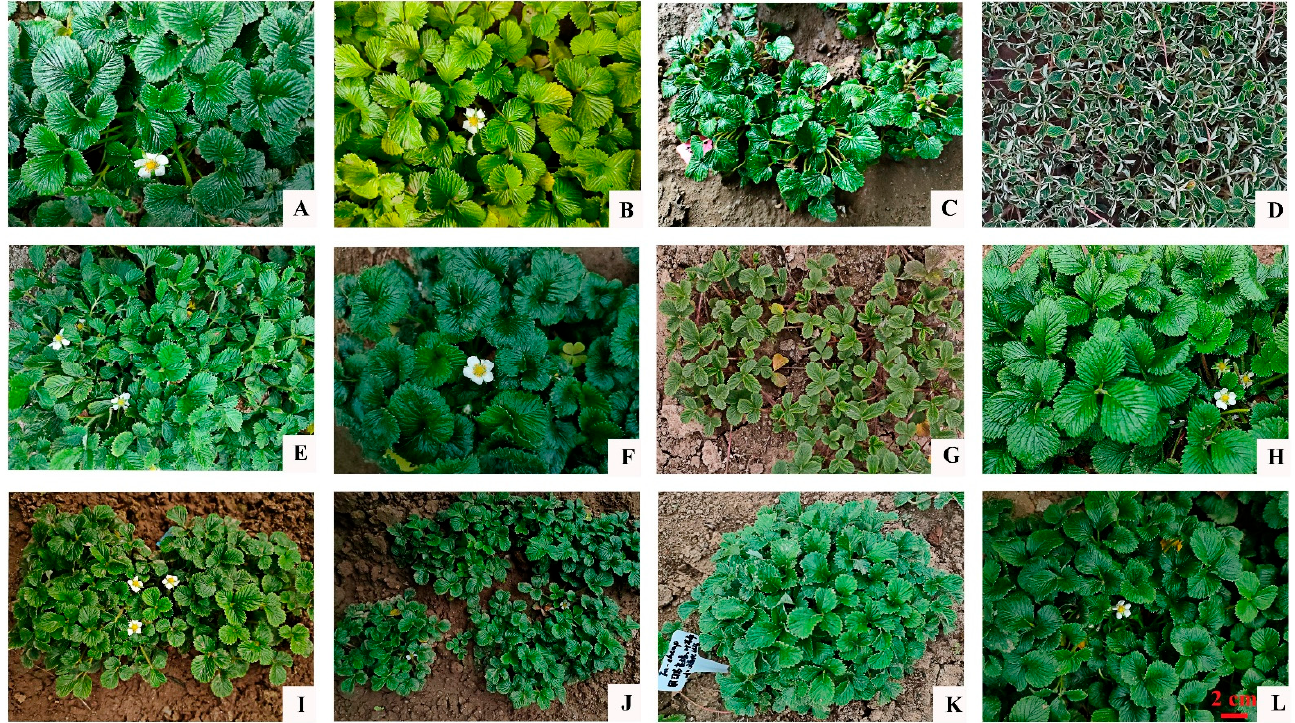
Figure 2. Plant and leaf phenotypes of 11 mutants in F. nilgerrensis. ( A ) DL: dark leaf; ( B ) YL: yellow leaf; ( C ) SGL: single leaf; ( D ) CL: curled leaf; ( E ) WL: wrinkled leaf; ( F ) RL: round leaf; ( G ) NL: narrow leaf; ( H ) LL: large leaf; ( I ) SL: small leaf; ( J ) DP: dwarf plant; ( K ) CP: clumped plant; ( L ) WT: wild-type plant. Scale bar = 2 cm.